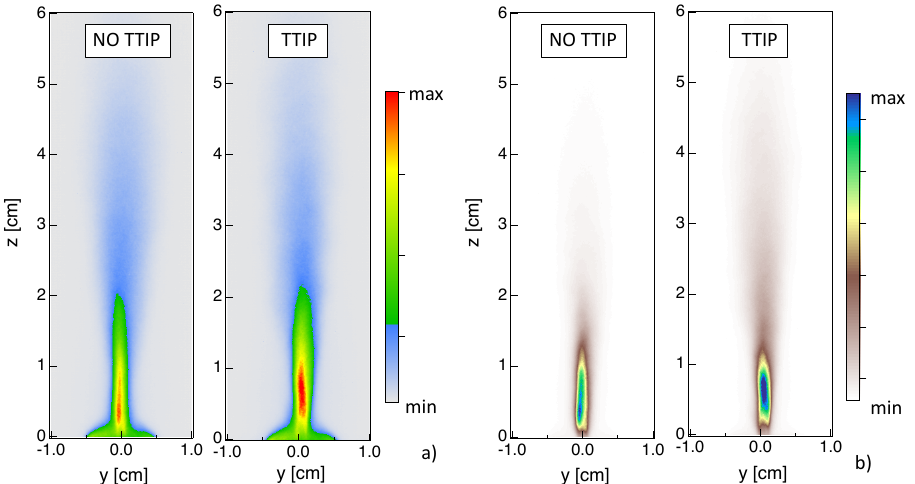
Figure 6. Time-averaged line-of-sight-integrated of ( a ) OH* and ( b ) CH* emission for the reactive cases (left) without and (right) with injection of